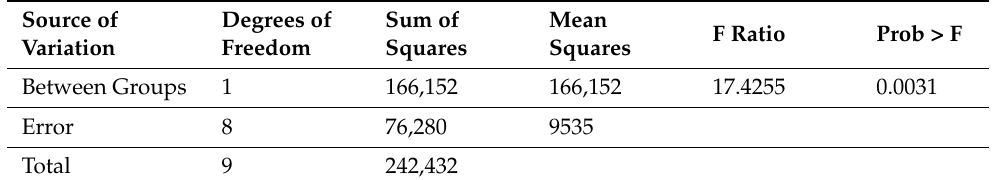
Table 14. One-way analysis of variance of glove material versus number of sandpaper touches to